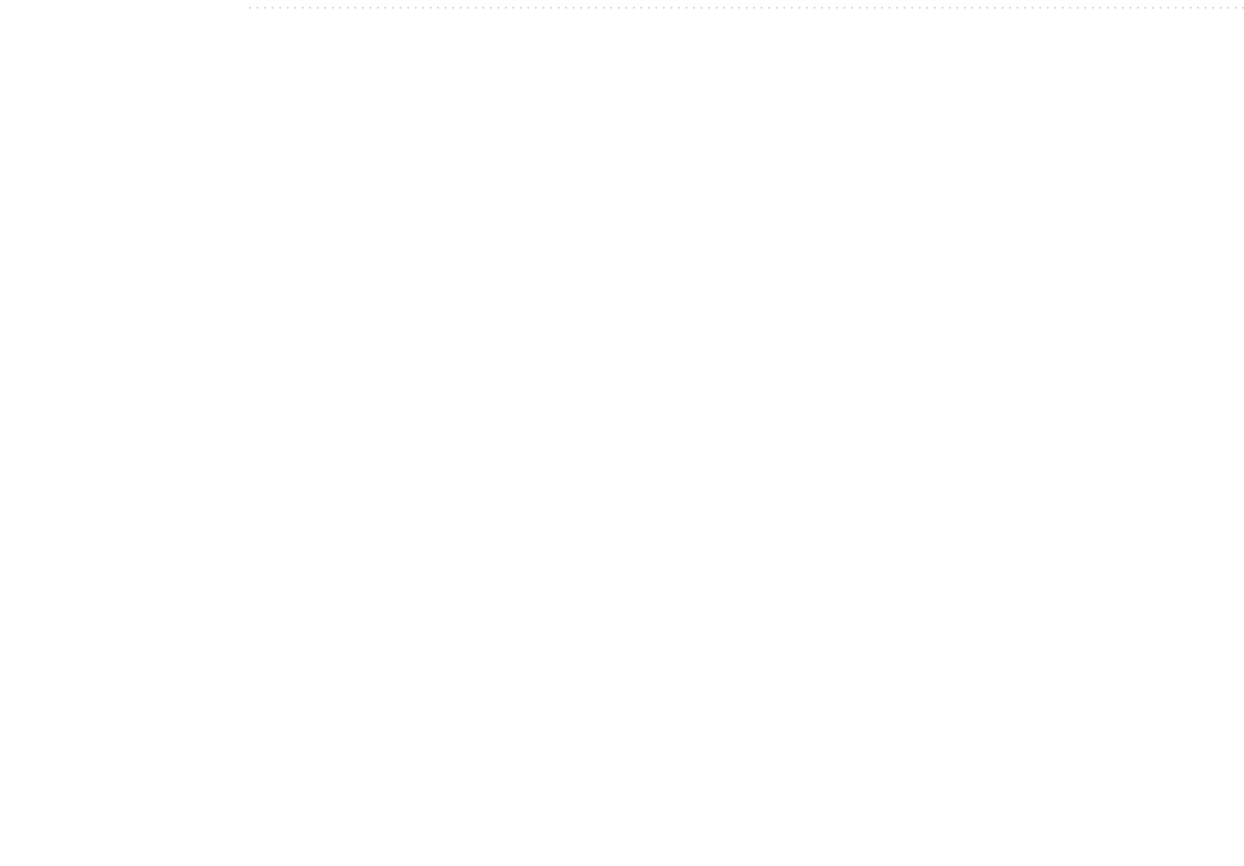
Figure 8. Average membership degree of index under X -conditional normal cloud